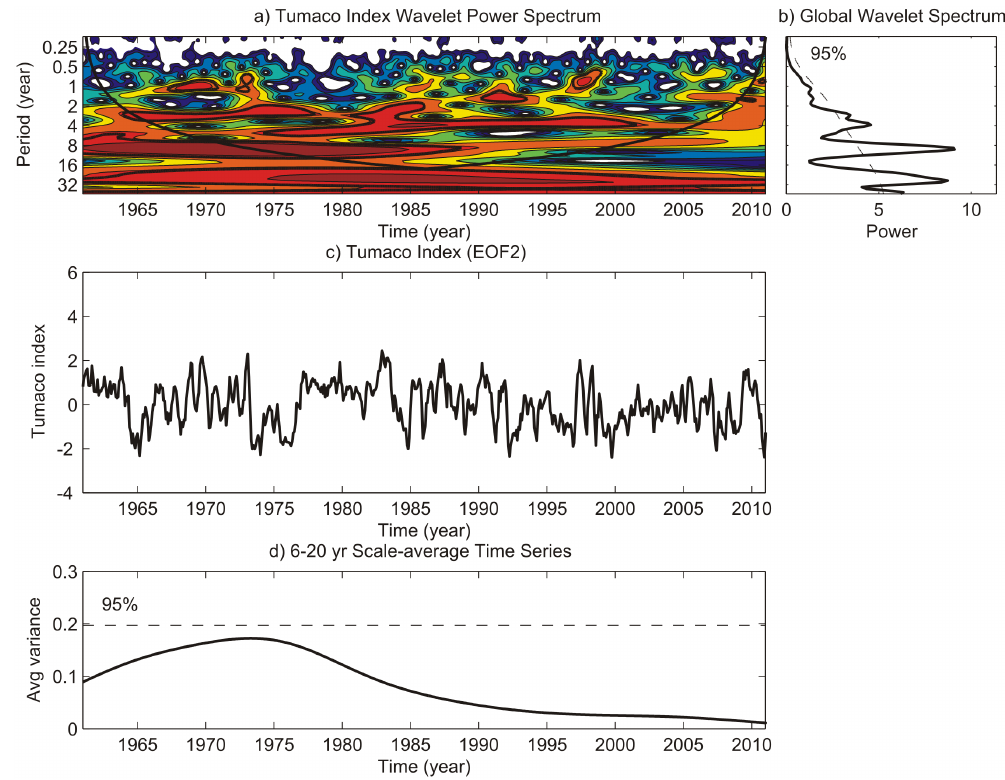
Fig. 4. Morlet wavelet power spectrum of EOF2 (a) , global wavelet spectrum (b) , time series of EOF2 (c) and 6–20yr scale-averaged power wavelet of the EOF2 time series of Tumaco sea–air variables (d)